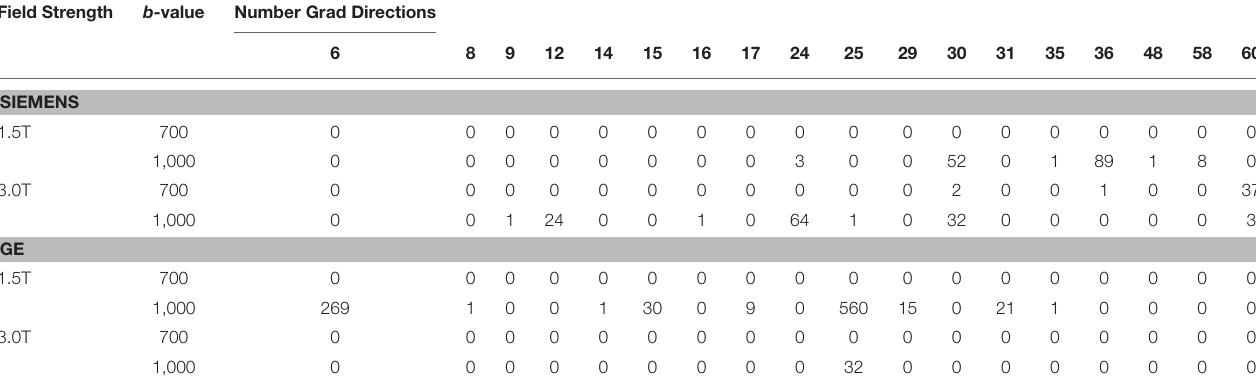
TABLE 1 | Composition of the 1,266 data sets used for analysis broken down by vendor and static field strength and b -value (rows), as well as the number of gradient directions (columns). Field